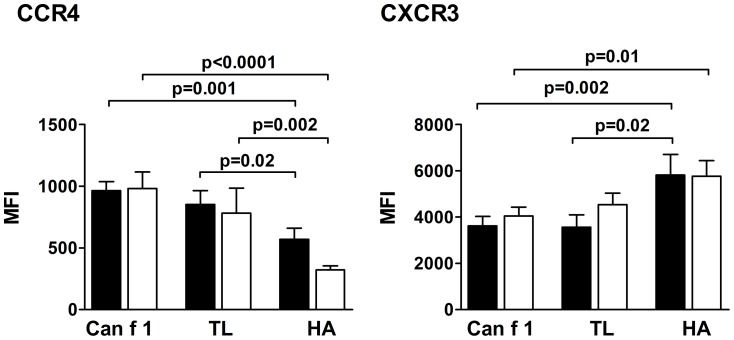
Expression of cell surface markers by peptide-specific TCLs.Expression of the cell surface markers CCR4 and CXCR3 on TCLs specific to Can f 1, TL and HA peptides from allergic (▪) and nonallergic (□) subjects. Results are expressed as mean fluorescence index (MFI)±SEM.